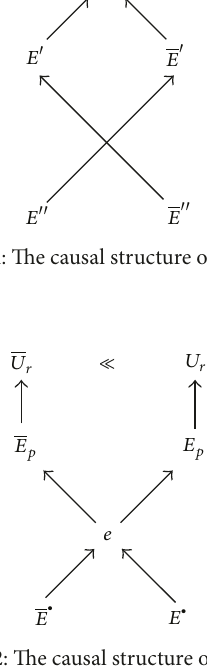
Table 1: The events and their broadcast time stamps in the RPS.